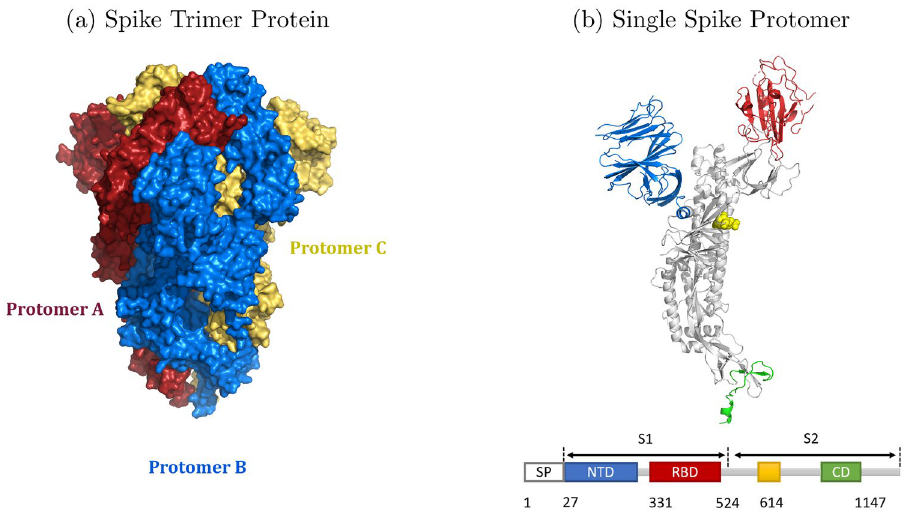
Figure 1. 3D Structure of a Spike Protein. ( a ) Crystal structure of the spike protein trimer (PDB ID: 6VXX) composed of three protomers colored red, blue, and yellow, and are all in a closed conformation. ( b ) A single protomer spike in a closed conformation containing a receptor-binding domain highlighted in red, an N-terminal domain highlighted in blue, a connector domain highlighted in green, and position 614 highlighted in